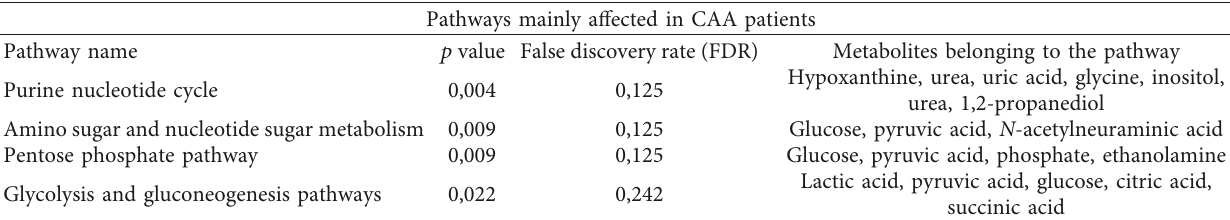
Table 3: Most important pathways based on the metabolic fingerprint.